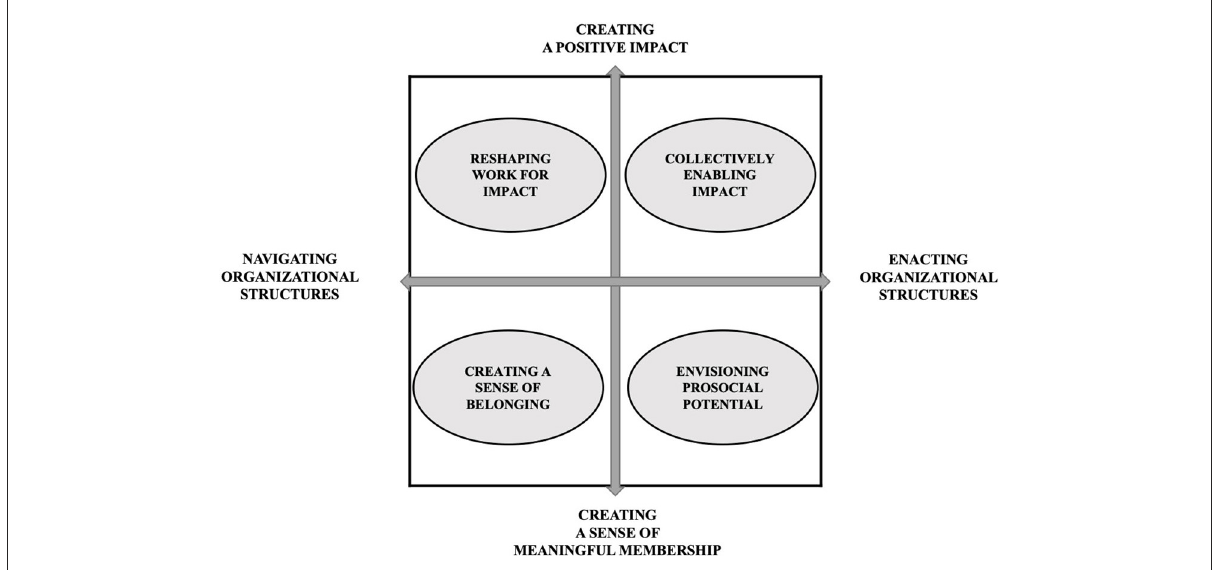
FIGURE3 A typology of meaning-infusing behaviours in the context of CSR in